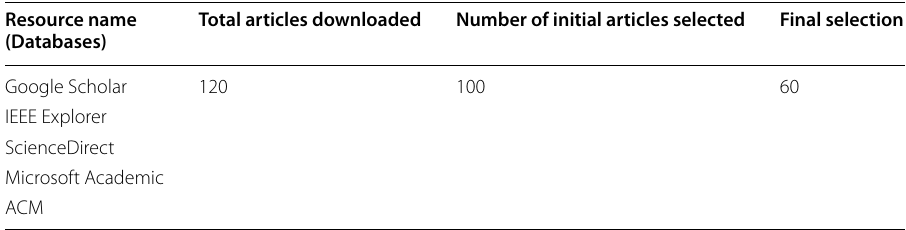
Table 1 Data source and search